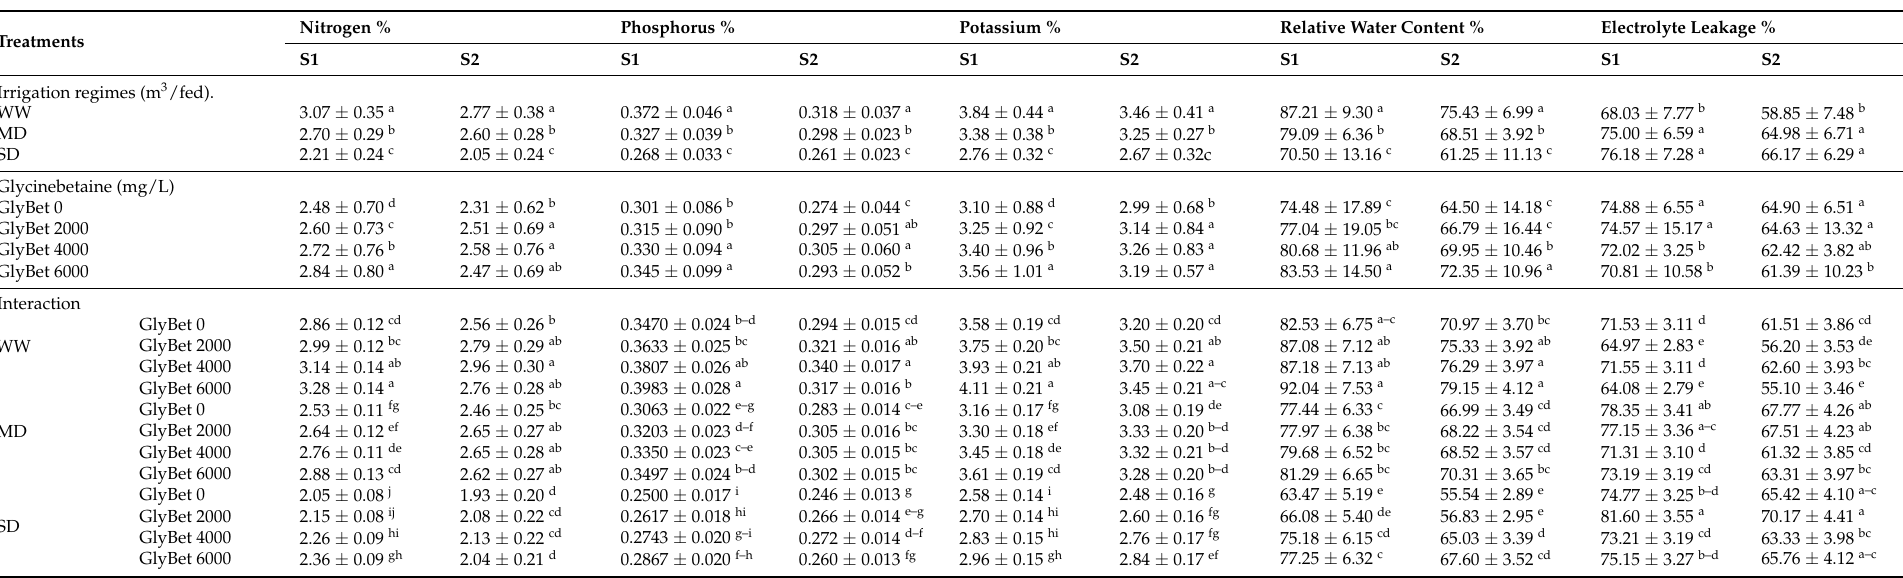
Table 4. Ion percentage, relative water content and electrolyte leakage of cucumber plant as affected by GlyBet concentration, irrigation regimes and their interactions at 35 days from sowing in both 2020 and 2021